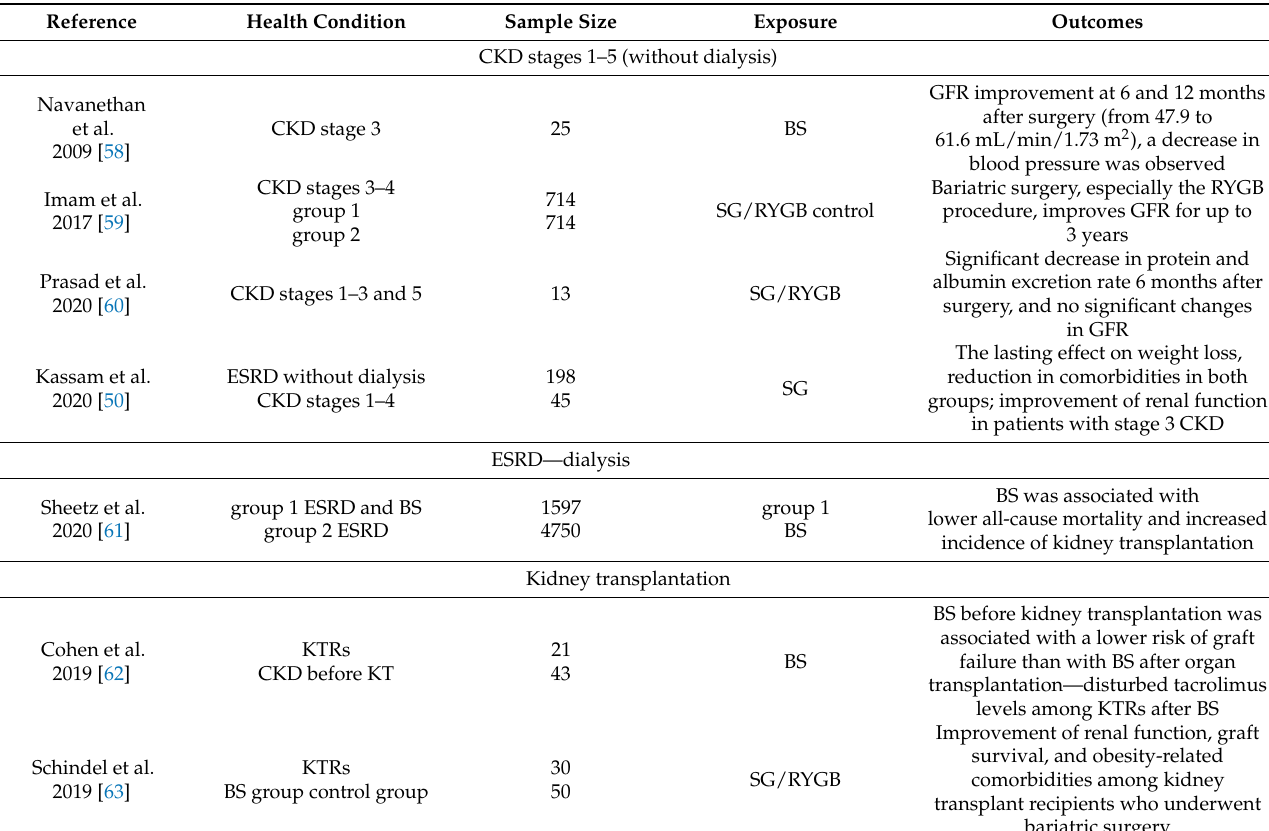
Table 1. Literature review on the effect of BS on patients with